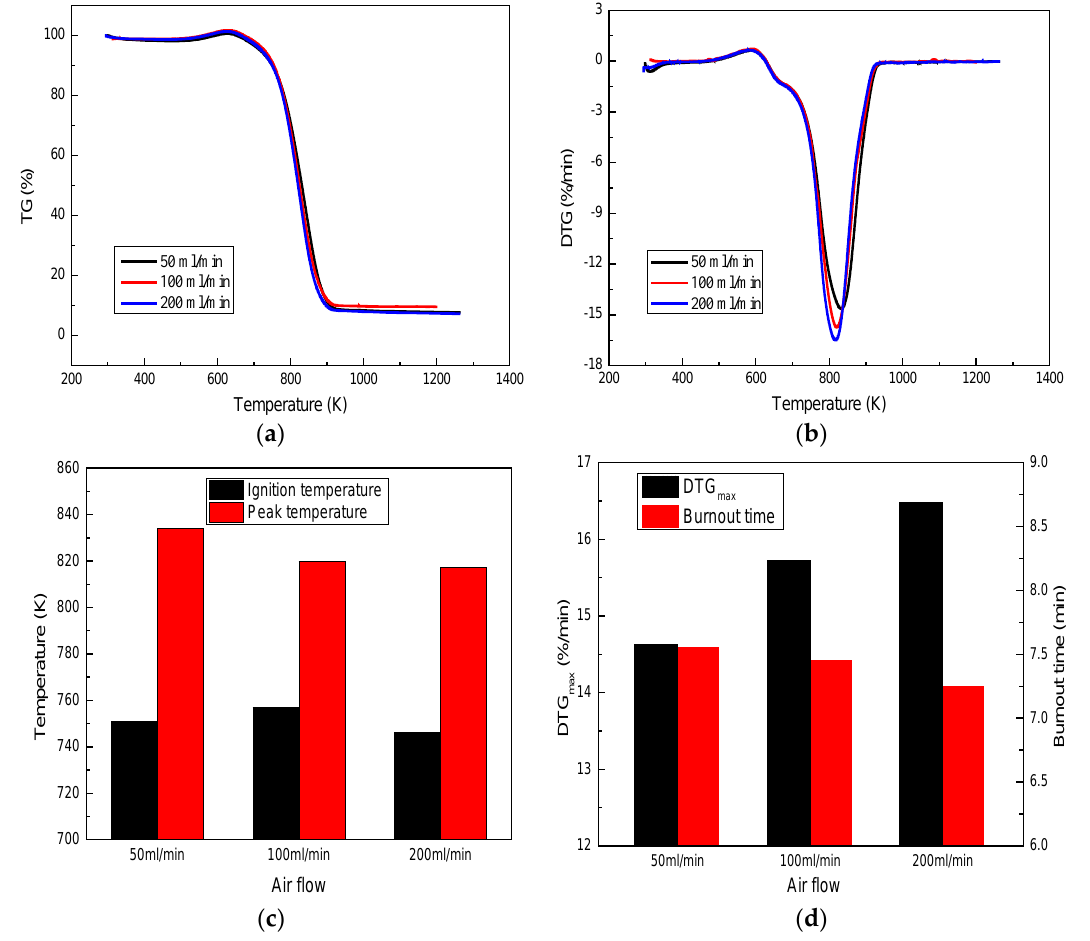
Figure 5. Effect of air flow on coal combustion: ( a ) TG profile; ( b ) DTG profile; ( c ) and ( d ) Coal combustion characteristics.